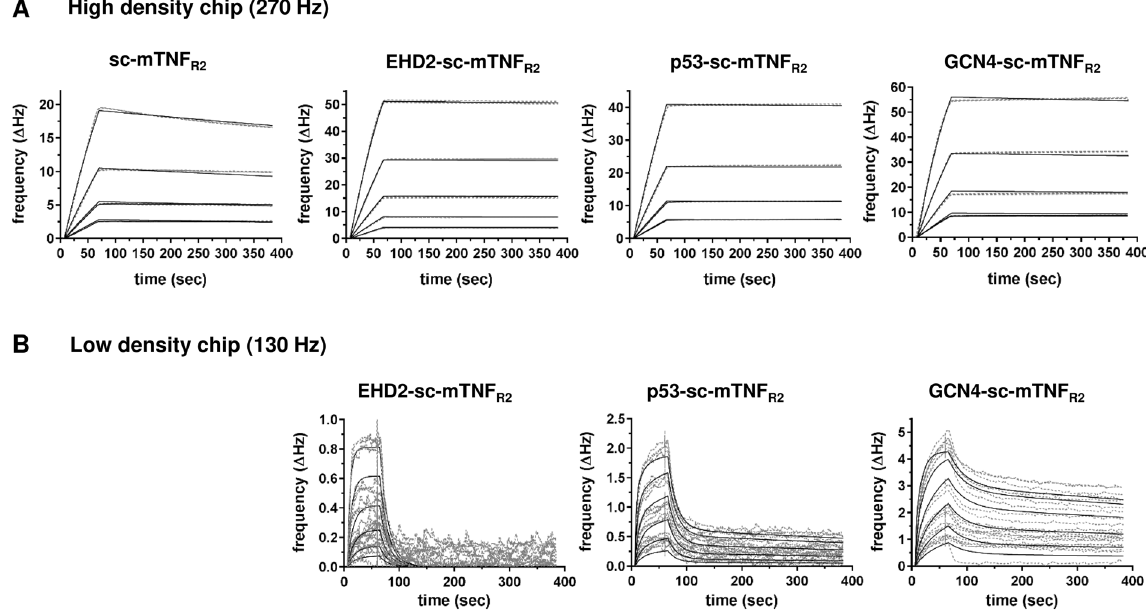
Figure 2. Dodecameric TNF muteins have higher affinity to TNFR2 Binding of oligomerized TNF muteins to mouse TNFR2 was analyzed by QCM at high (A; 270 Hz) and low (B; 130 Hz) density of immobilized mouse TNFR2-Fc. Oligomerized TNF muteins were analyzed at concentrations between 2–32 nM ( A ) or 8–256 nM ( B ) at 37 °C in triplicates for each concentration (dashed lines = data curves, solid lines = fitted curves).